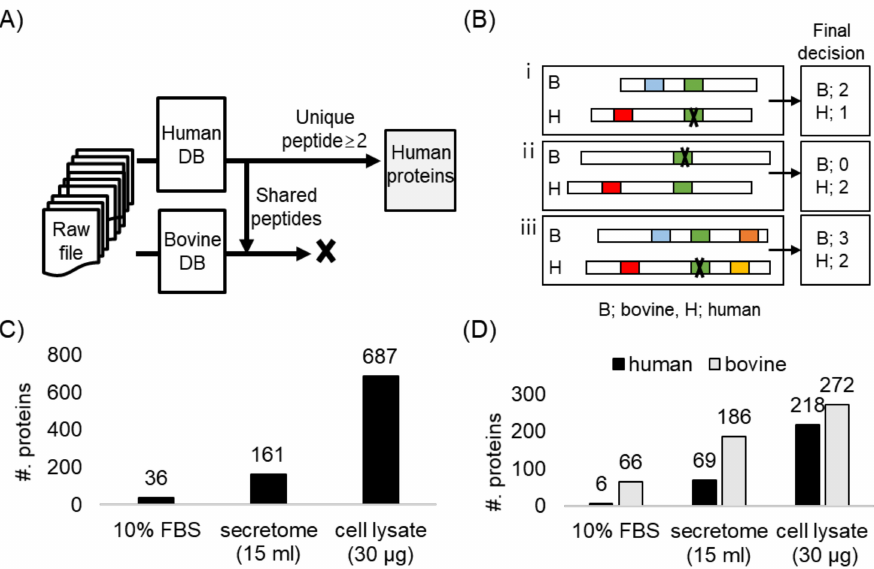
Figure 2. Analysis of secretome in 10% FBS-supplemented media. ( A ) A schematic diagram of two independent searches using human and bovine databases to minimize the false-positive identification possibly derived from 10% FBS. ( B ) Criteria to determine the origin of shared peptide between human and bovine proteins. Each horizontal bar indicates the whole sequence of a protein. The color box inside the bar indicates the peptides identified in each database, and the green box indicates the shared peptide between human and bovine proteins. Cross marks in black indicate that the peptide is assumed not to be derived from this protein. In the final decision, only proteins with two or more peptides are counted. (i) it was determined that only bovine protein was identified, (ii) determined that only human protein was identified, (iii) both bovine and human proteins were determined to be identified. ( C ) Number of identified proteins after enrichment using only the human database. ( D ) Number of identified proteins after enrichment using both the human and bovine databases and applying the